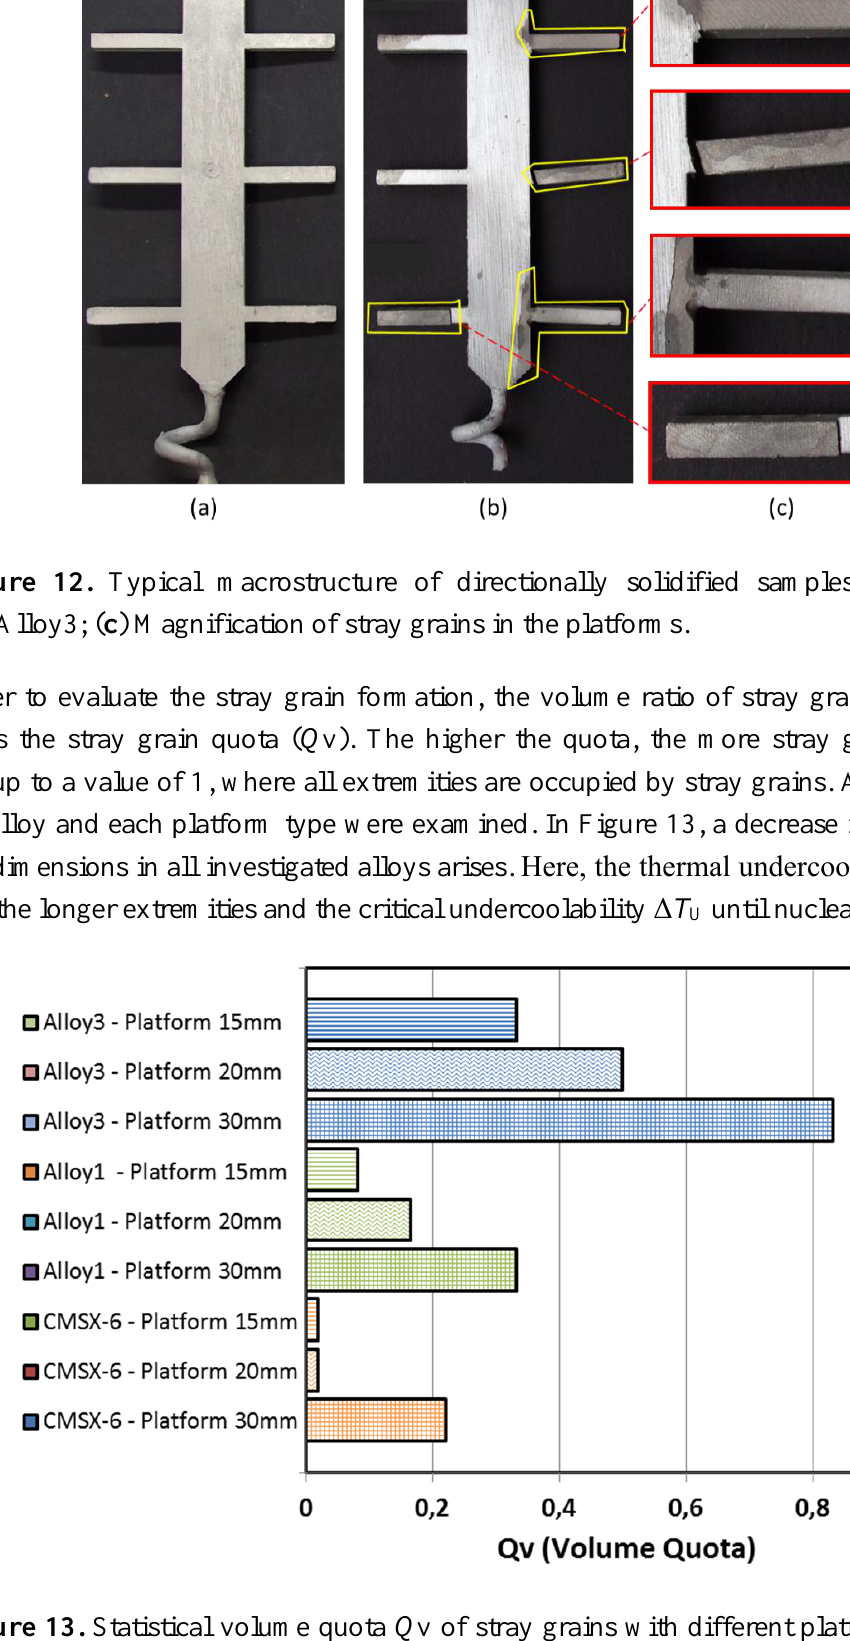
Figure 13. Statistical volume quota Q v of stray grains with different platform dimensions of CMSX-6, Alloy1 and